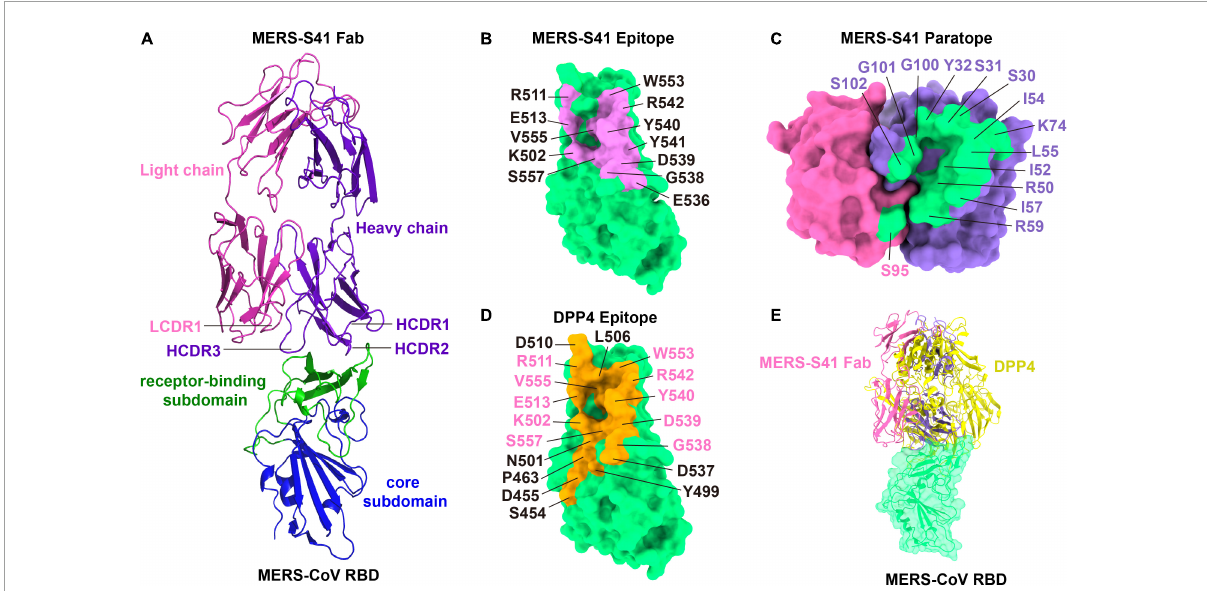
FIGURE3 The binding interface of the MERS-S41 Fab and MERS-CoV RBD. (A) Structure of the MERS-S41 Fab bound to RBD. The RBD core subdomain is colored in blue, the receptor-binding subdomain in green, the MERS-S41 light chain in magenta, and the MERS-S41 heavy chain in purple. (B) The MERS-S41 epitope. The MERS-CoV RBD is shown in green surface with residues within 4Å of MERS-S41 Fab labeled and colored pink. (C) The MERS-S41 paratope. The MERS-S41 light and heavy chain surfaces are shown in magenta and purple, respectively. Residues within 4Å of the RBD are colored green and labeled in either magenta or purple, depending on whether they are from the light or heavy chain. (D) The DPP4 binding site. The MERS-CoV RBD is shown in green surface with residues within 4Å of DPP4 colored orange and labeled. Residues labeled in pink are also in the MERS-S41 epitope. (E) The RBD/MERS-S41 Fab structure superposed on the RBD-DPP4 structure (PDB 4L72). The MERS-CoV RBD is shown in green surface, DPP4 shown in yellow cartoon, and MERS-S41 Fab in pink